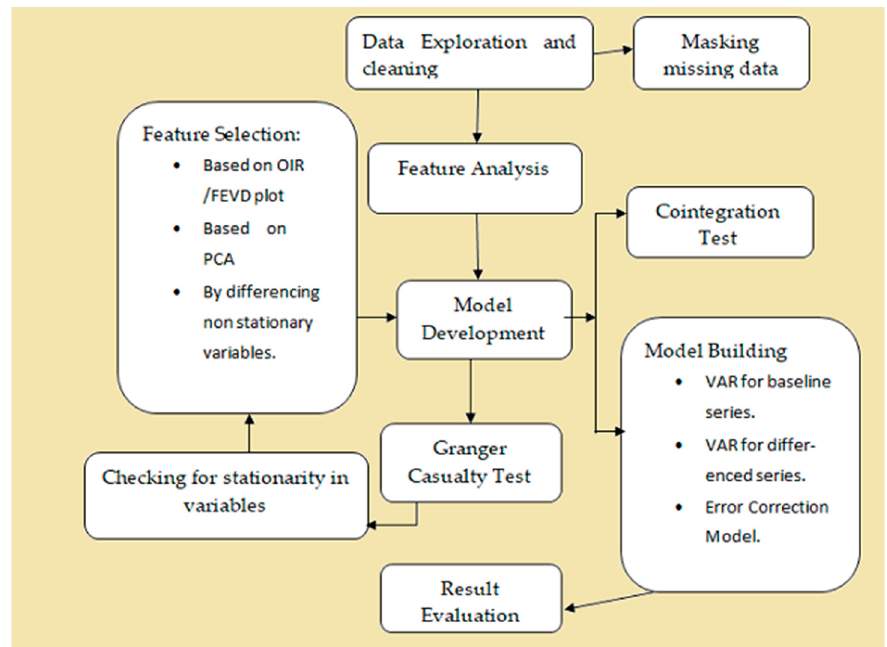
Figure 2. Flowchart of working model VAR/VECM.